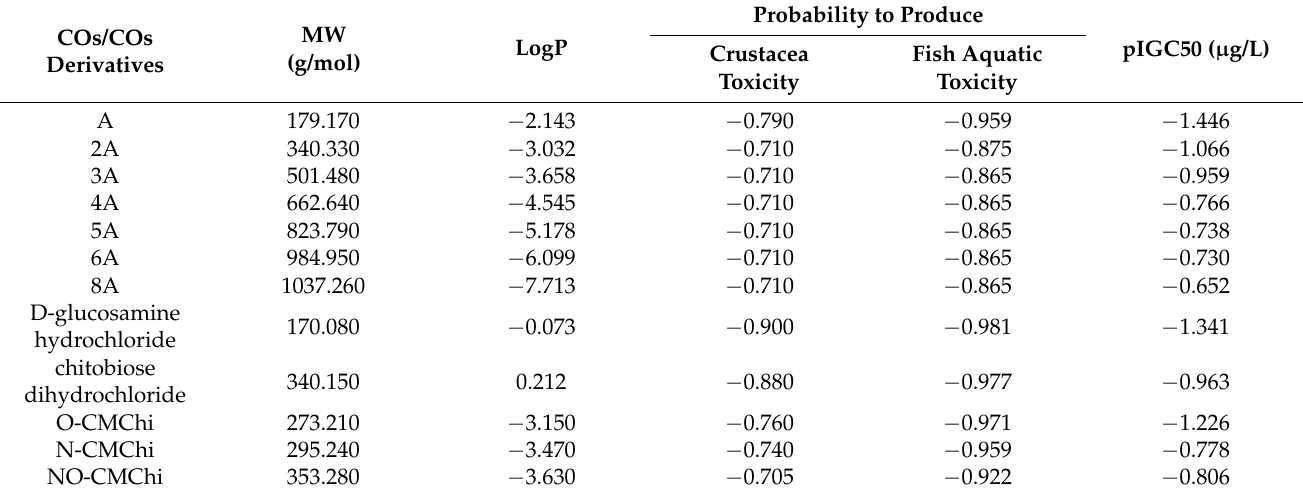
Table 1. Physicochemical properties and predictions obtained using admetSAR2.0 tool and regarding the effects of totally acetylated chitooligosaccharides (COs) and of COs derivatives on aquatic